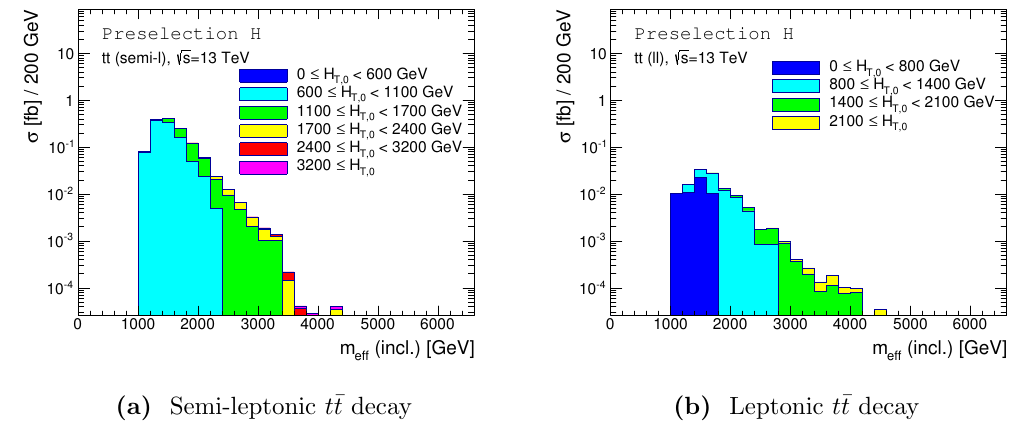
Figure 4. Same as in (cid:12)gure 3, but for the t (cid:22) t production